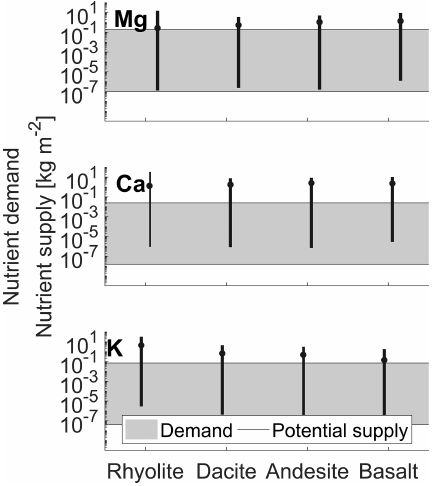
Figure 8. Potential macronutrient (Mg, Ca, and K) supply of dif- ferent rocks for closing projected P gaps of (cid:28) 1 to 17.1gPm − 2 . Medians and ranges (5th and 95th percentiles) of potential supply based on rock